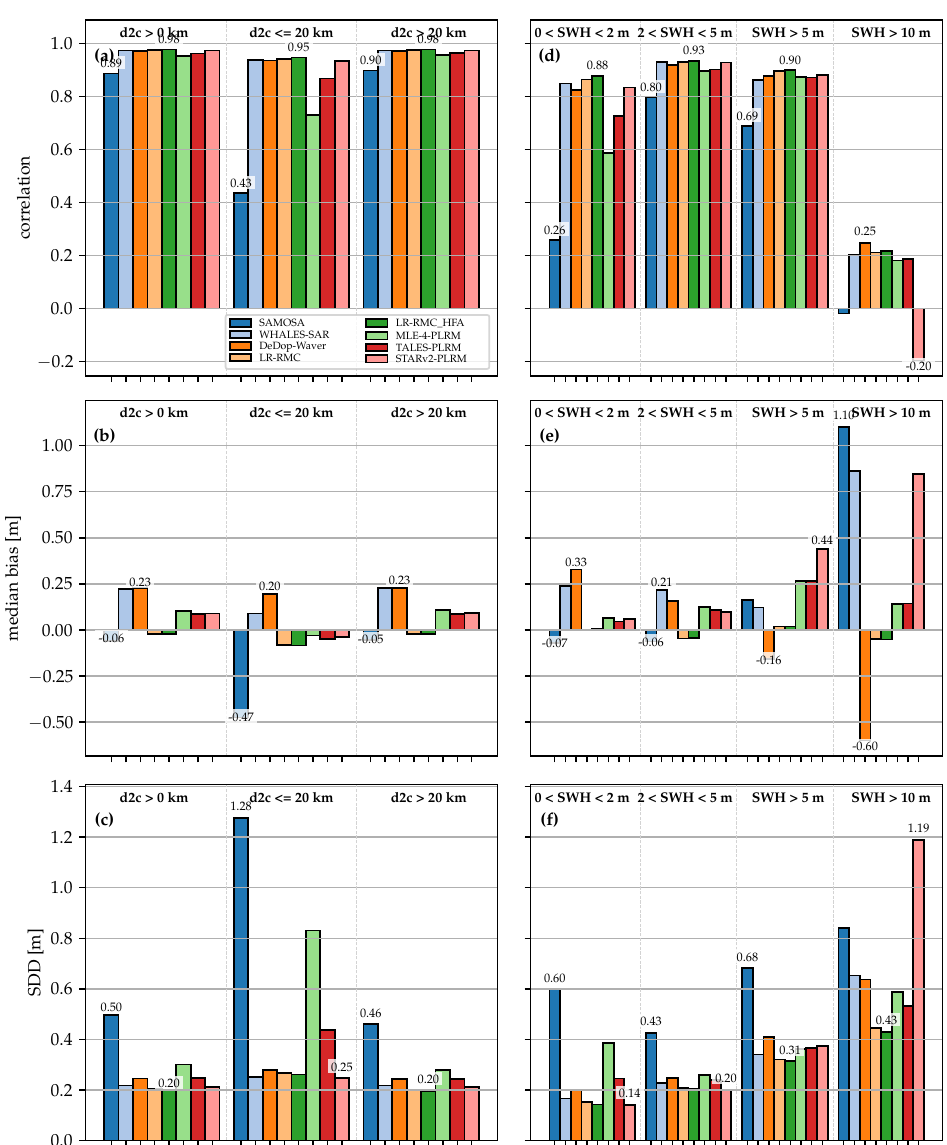
Figure 10. Comparison of the ( a,d ) correlation coefficient, ( b,e ) median bias, ( c,f ) SDD against ERA5-h model of the individual S3A retrackers as a function of dist2coast and of SWH, respectively. As the majority of the retrackers (WHALES-SAR, DeDop-Waver, LR-RMC/LR-RMC_HFA and STARv2-PLRM) show a very good correlation in the coastal zone, the SDD also amounts to a very low value of around 0.25 m. All retrackers show an increasing SDD for the average, high, and very high sea states starting from around 0.30 m. Particularly the PLRM variants (excluding STARv2-PLRM because of its inherent denoising) show increased SDDs both in the coastal zone and for low and very high sea states. This is in agreement with the findings of (Figure 21 [28]), which demonstrates a significantly increased SD for TALES as compared to an improved SAMOSA-based DDA retracker (SAMOSA+) within the coastal zone. The authors of [23] have assessed SDD values of 0.30 and 0.18 m